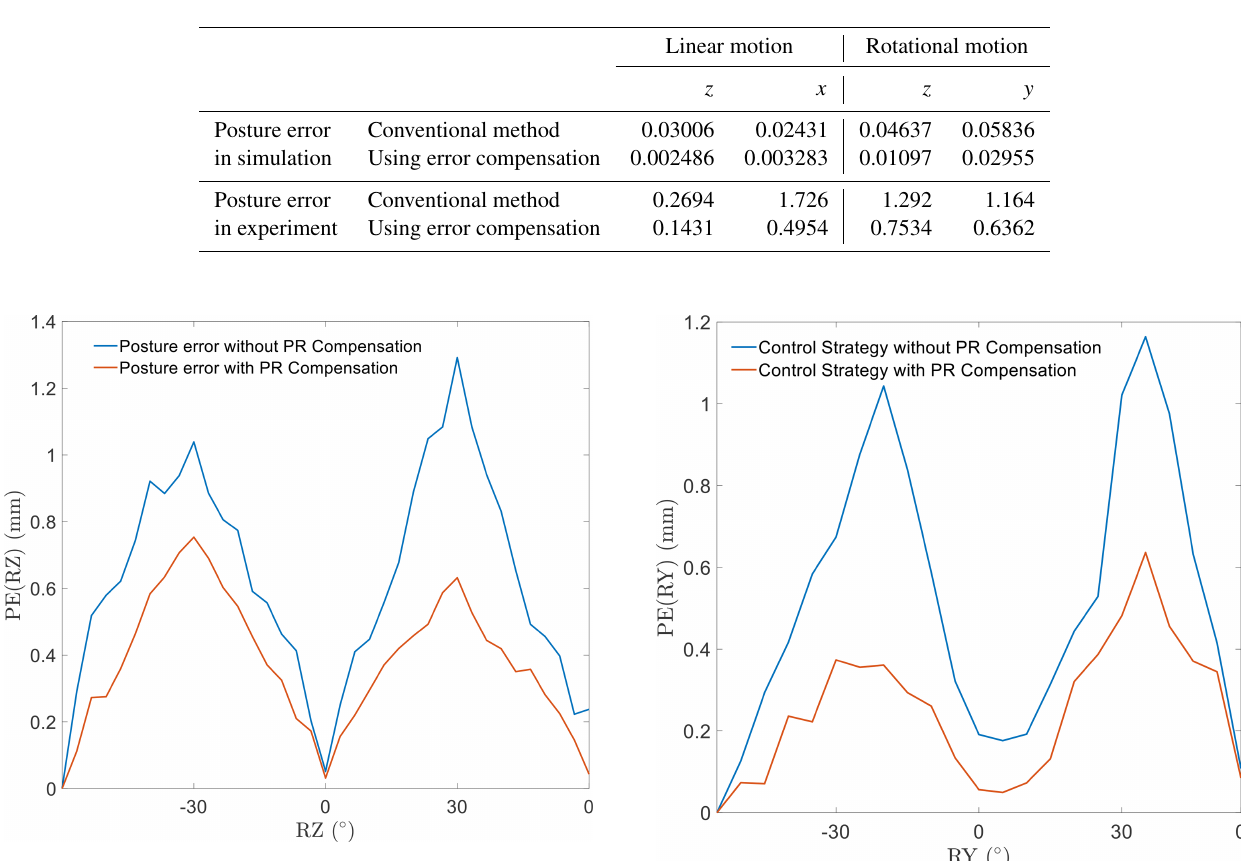
Table 1. Comparison of maximum error in simulation and experiment (unit: mm).